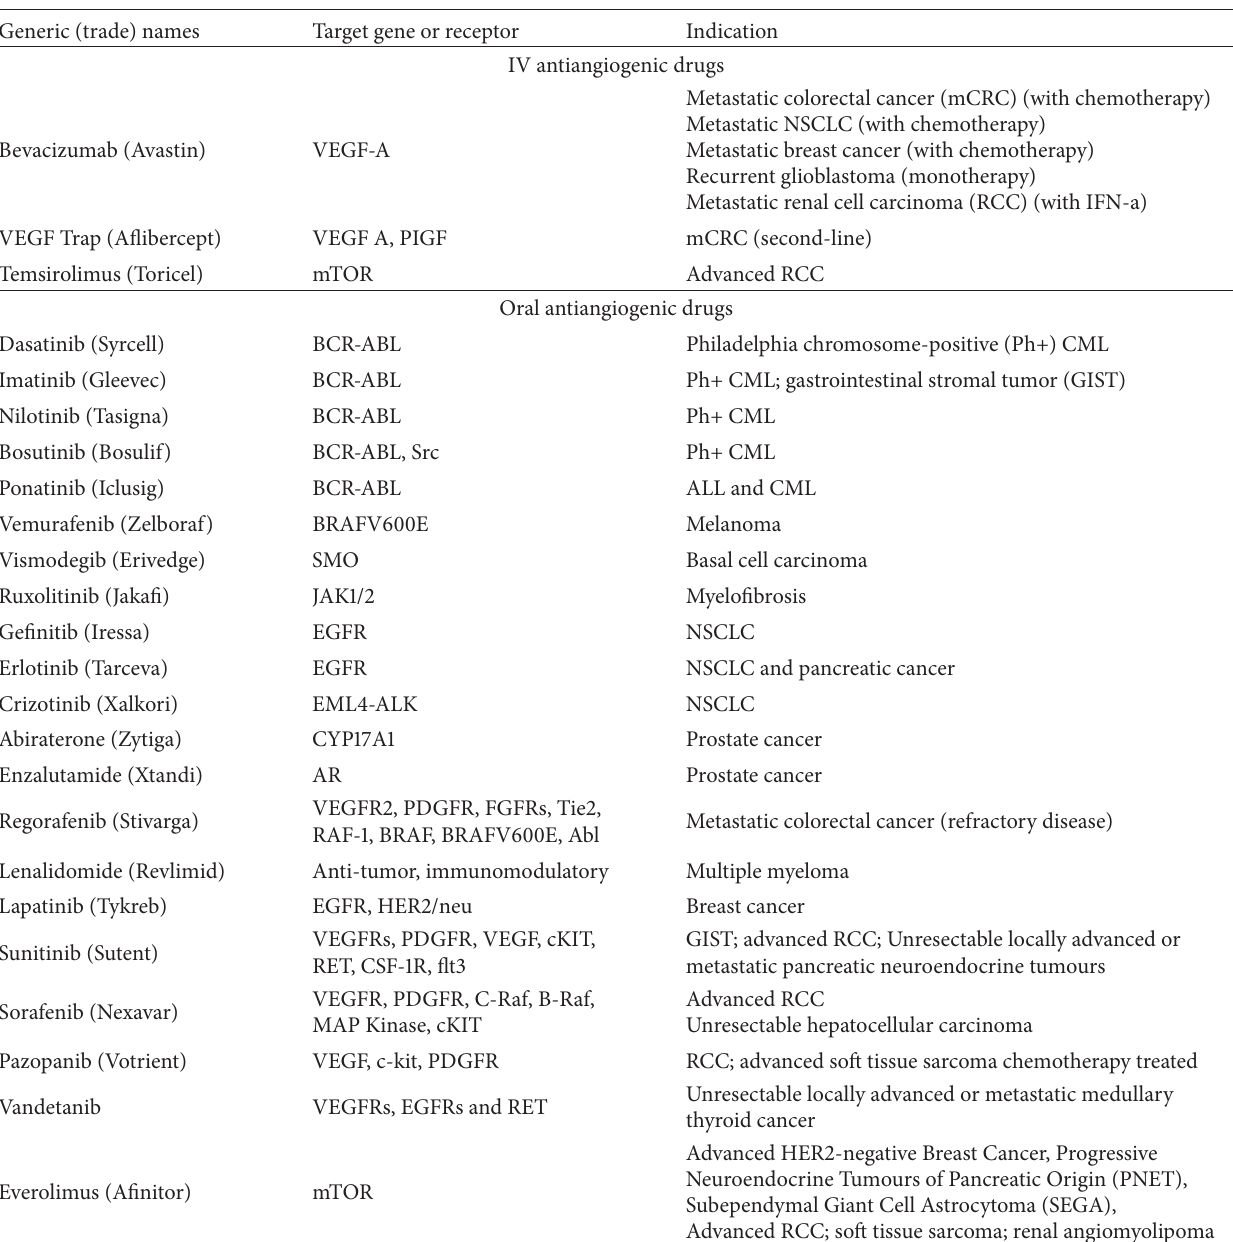
Table 1: Selected FDA approved targeted anticancer